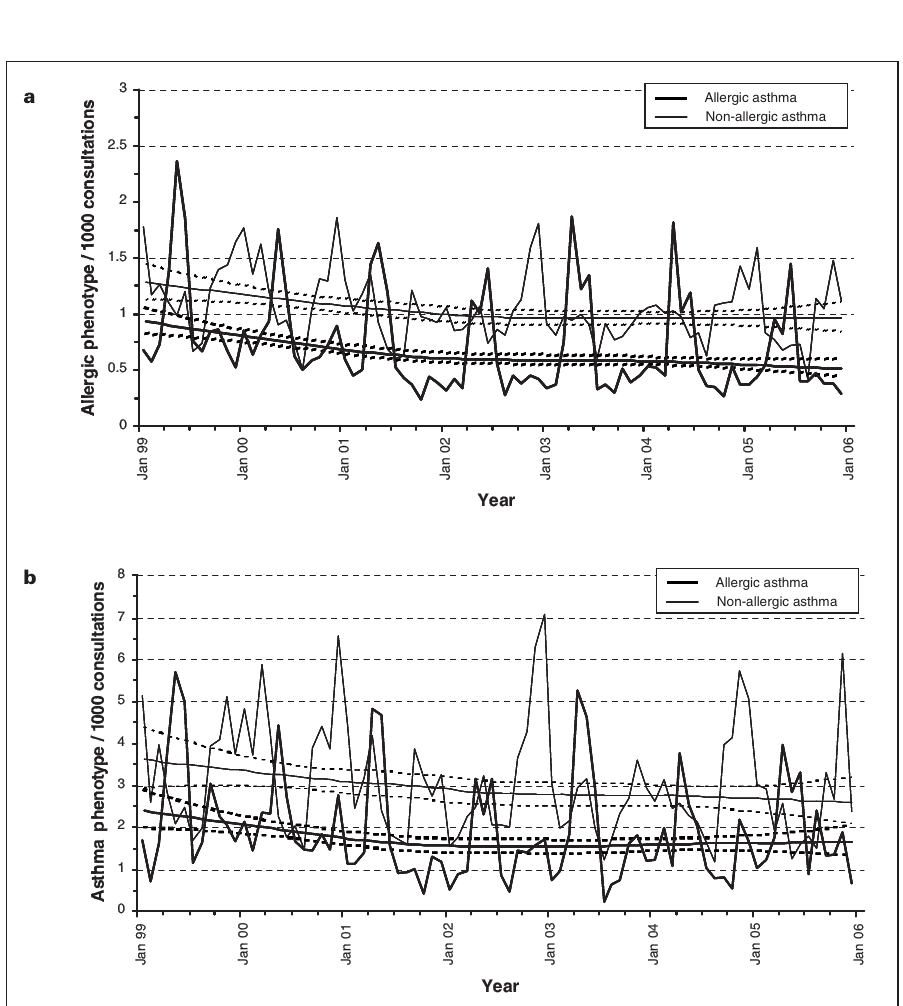
Figure 2 Long-term and short- term trends in first and subsequent episodes of asthma, 1994–2002. Four- weekly rates of first episodes per 1000 consultations (grey) and subsequent episodes (black). Left panel: Long-term trend estimates with loess smoother (solid line) and the corre- sponding upper and lower pointwise twice-standard-error curves (dashed lines); f = 2/3. Right panel: Short-term trend esti- mates with loess smoother (solid line) and the correspon- ding upper and lower pointwise twice-stan- dard-error curves (dashed lines); f = 3/10. (reproduced with permission from Int J Epidemiol 2005;34:1015).